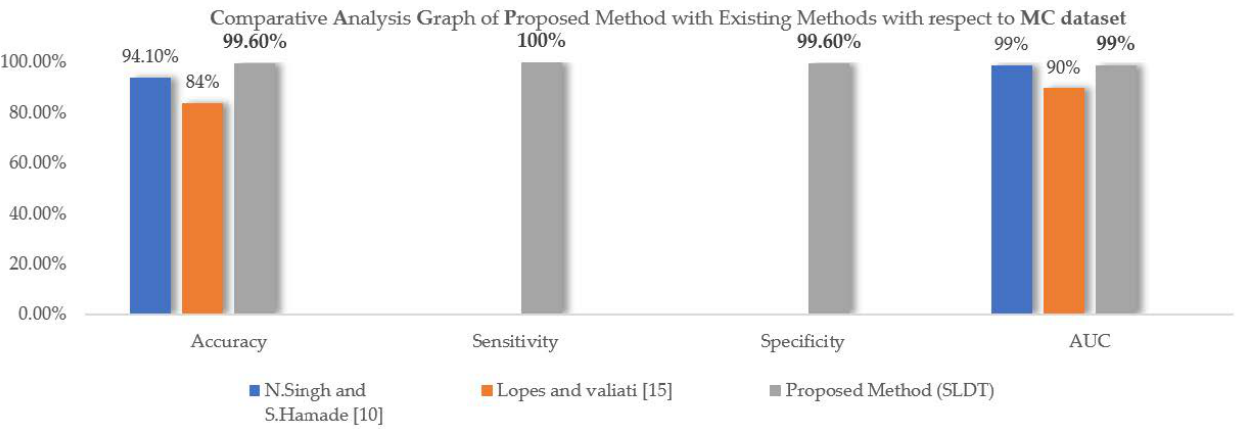
Figure 9. Comparative analysis graph of the proposed method with the existing method with respect to combined dataset 1 (MC and CHN).